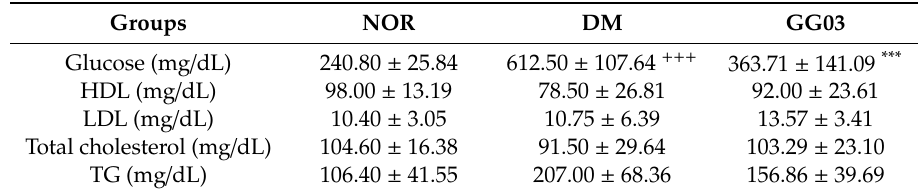
Table 5. Lipids in the serum of